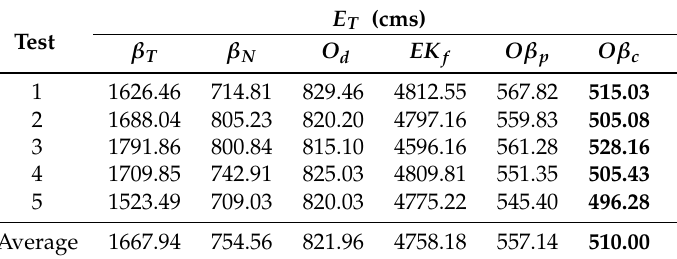
Figure 12. Trajectory 1: Position of NSBot2 in terms of x , y and θ based on odometry ( top ); temporal localization-error analysis ( bottom ). Table 3. Localization error for Trajectory 1. The least error for each row is written in bold.